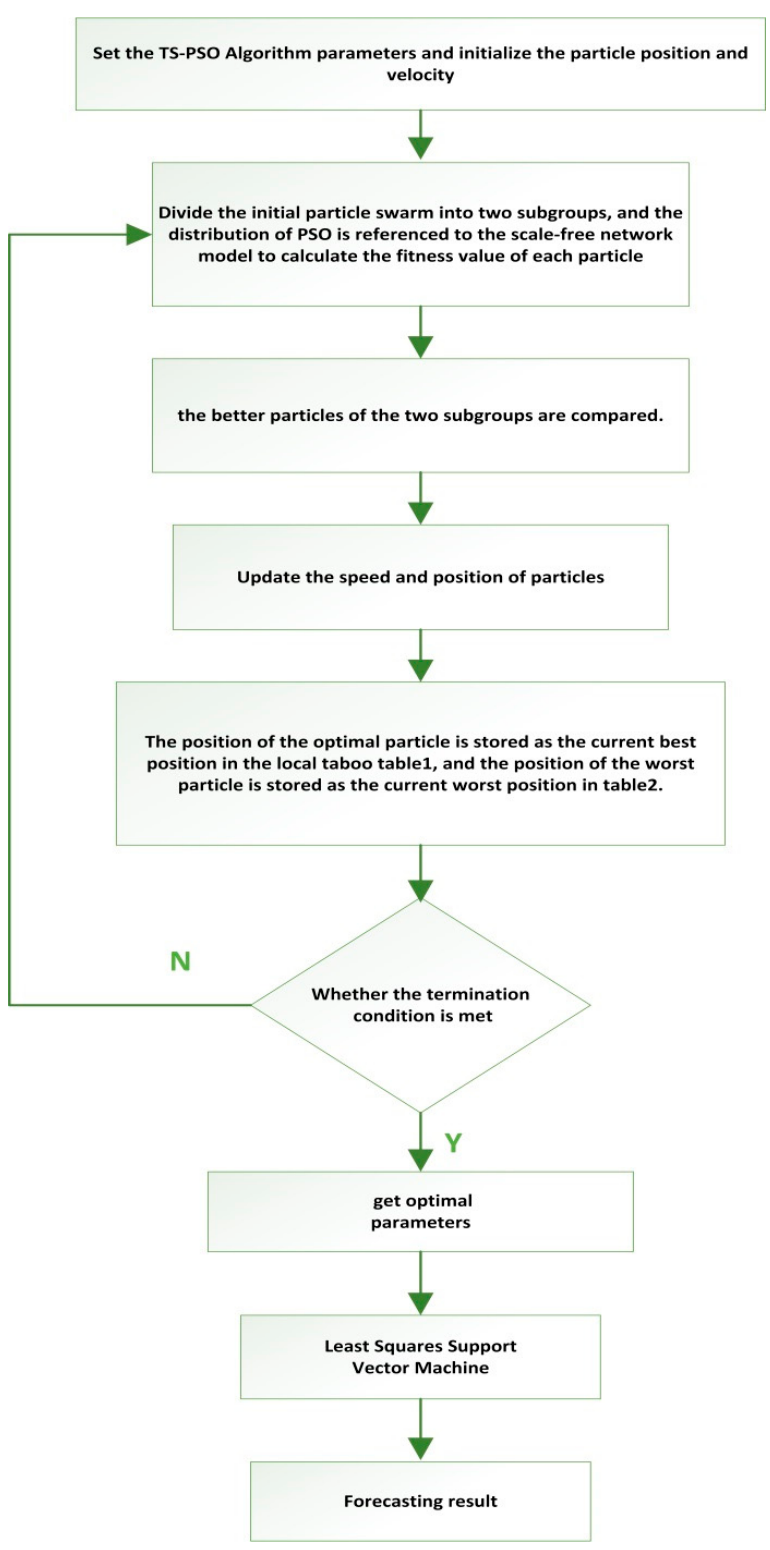
Figure 2. The flow chart of Least Squares Support Vector Machine Optimized by TS-PSO Algorithm.